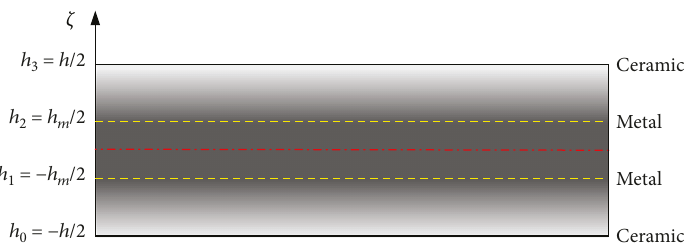
Figure 3: The section of the FG sandwich blade.